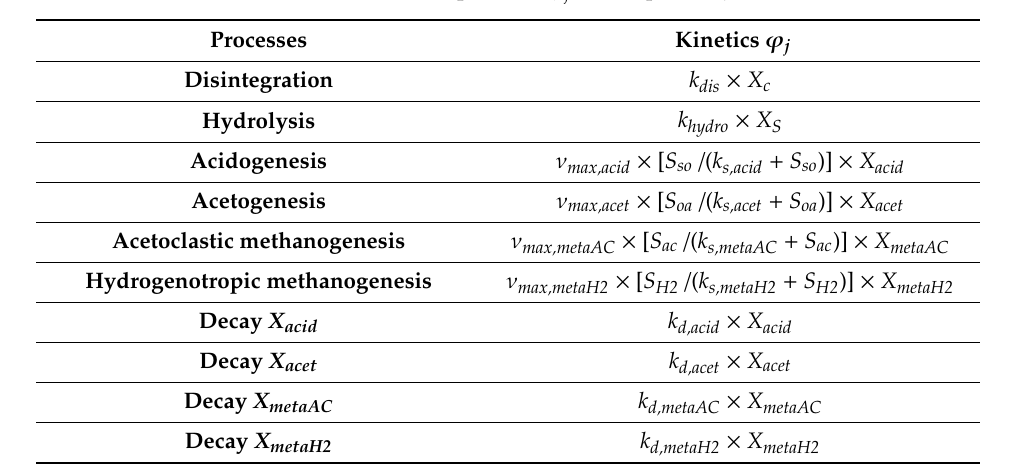
Table 3. Kinetic equations ( ϕ j ) of the process j